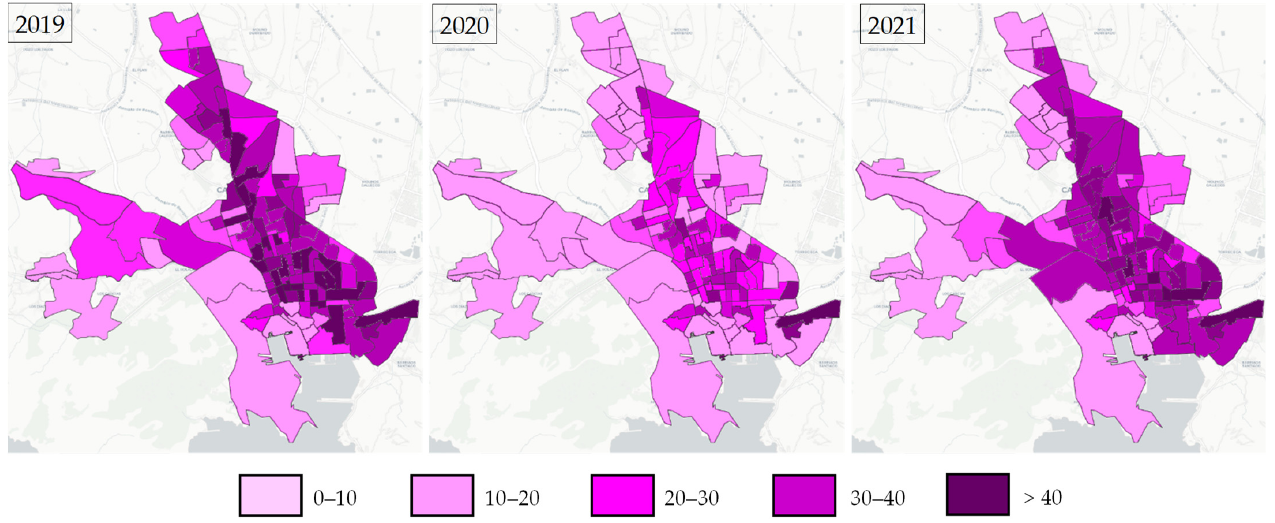
Figure 13. Evolution of the spatial distribution of the EAQI values in the city’s sectors in the months of March and April of 2019, 2020, and 2021.